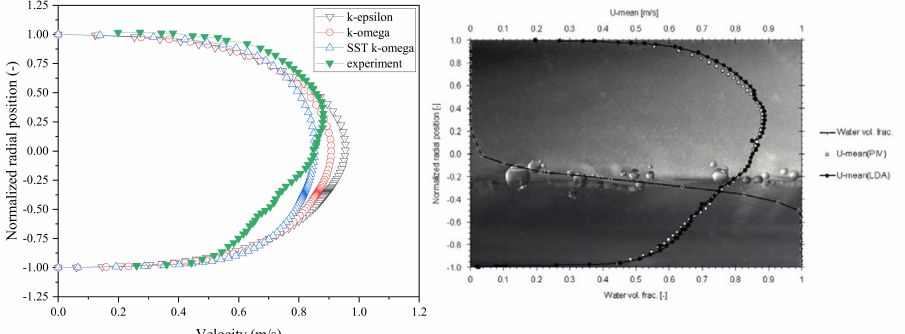
Figure 8. Velocity distribution at pipe centerline under different turbulence models given mixed velocity 0.68 m/s and water cut 0.25